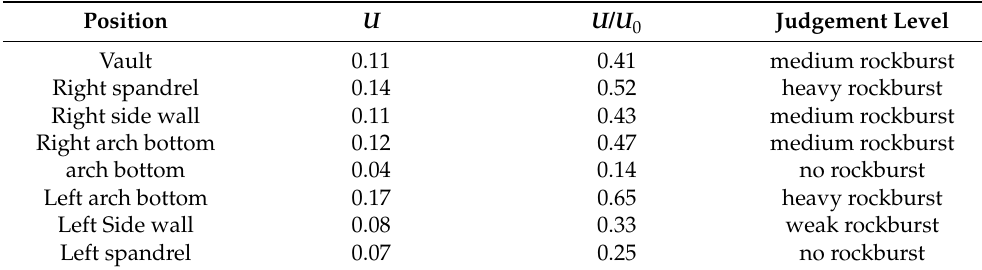
Table 8. Predicted results of rockburst